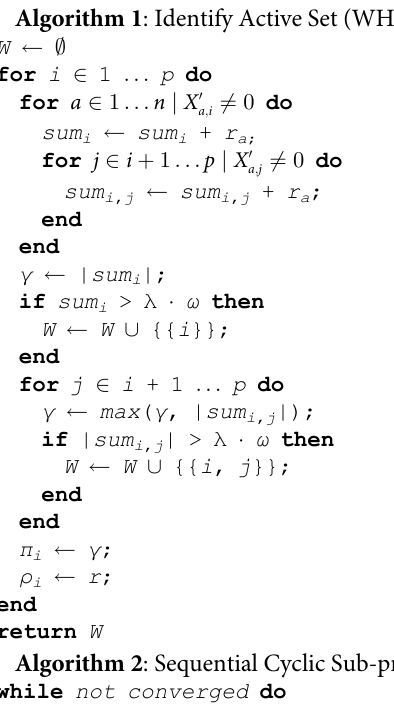
Algorithm 2 : Sequential Cyclic Sub-problem